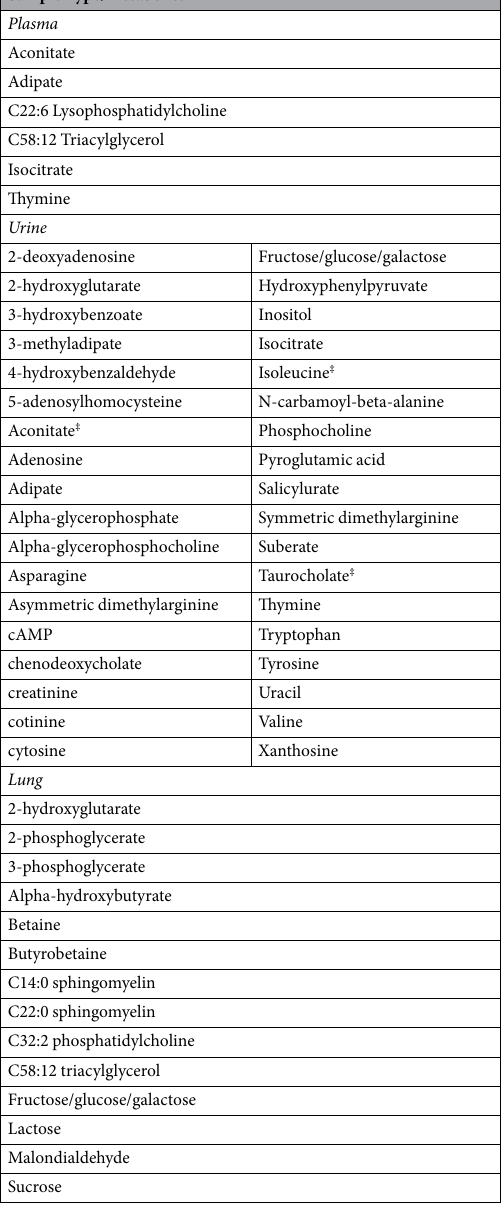
Table 5. Metabolites with significant (p < 0.05) gene-by-environment interactions. ‡ Denotes significance at a false discovery rate (FDR) <